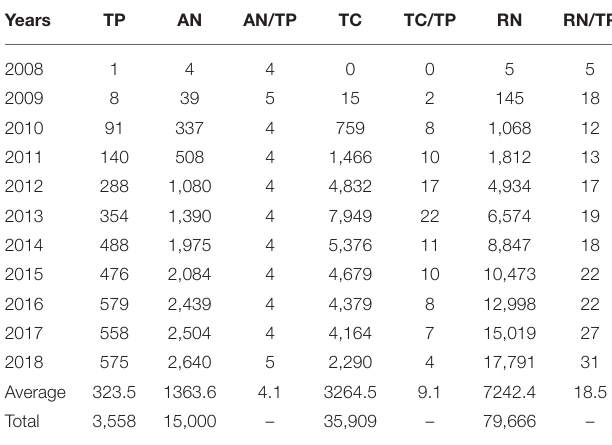
TABLE 1 | Chinese scholars’ publications characteristics on SG from 2008 to